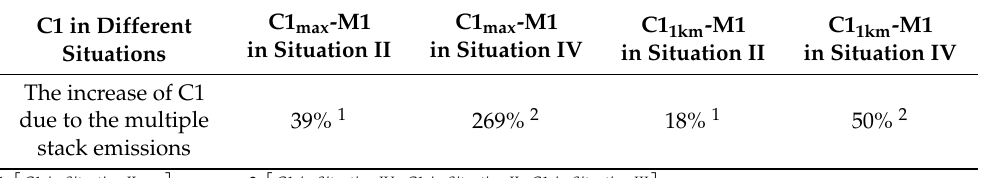
Table 5. BL3 simulations: The increase of C1 due to the multi-stack emissions in different